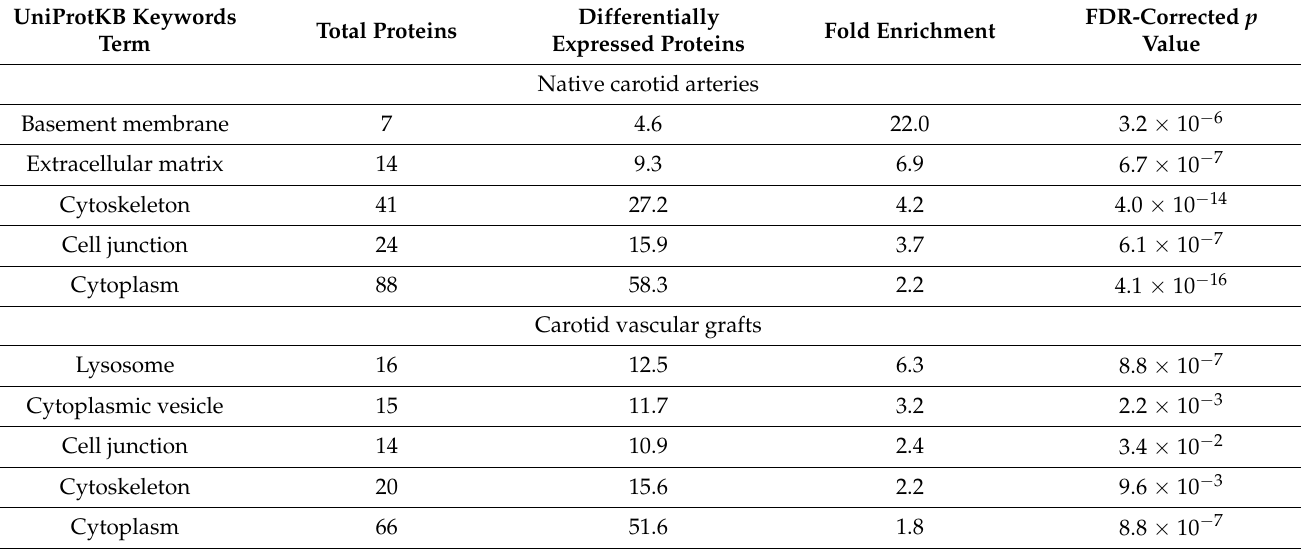
Table 3. Distribution of proteins which are upregulated in either native carotid arteries or TEVGs across various cellular compartments (annotated according to the UniProtKB Keywords database).